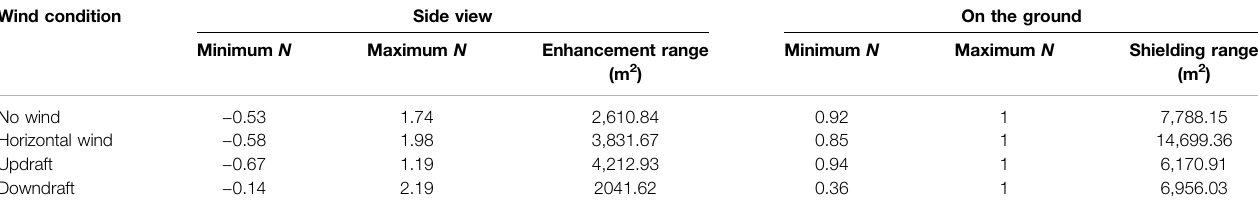
TABLE 1 | Properties of distortion caused by corona charges in the E- fi eld (N and the range of in fl uence) under different wind conditions when the background E- fi eld reached its maximum value. Wind